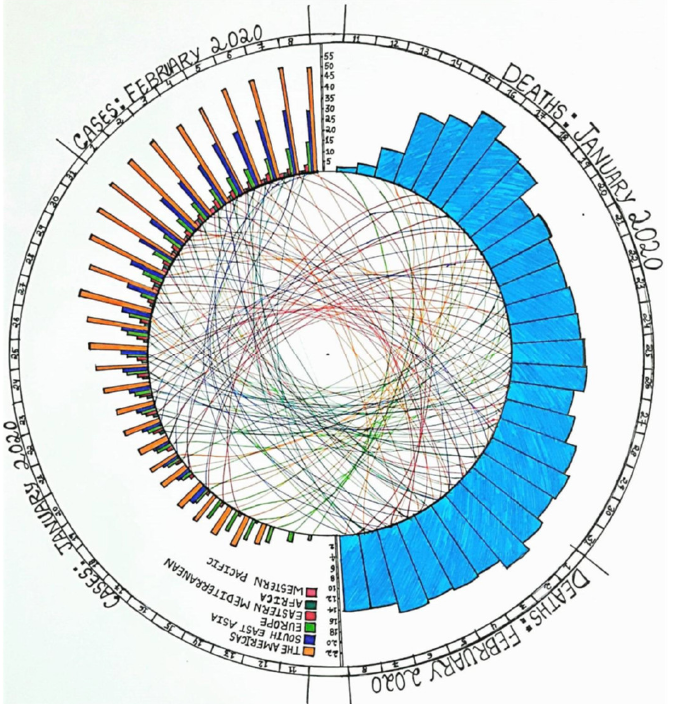
Figure 1. Initial epidemiology of COVID-19 in 2020. This circular plot represents the progressive increase in the number of infections/cases in the beginning of 2020 world wide. The left half of the circle shows the number of increasing cases per country over a period of one month (11 January to 8 February 2020). Right half of the circle shows the number of deaths over the same period of time from the countries listed taken together. Correlations are shown as lines in the center of the circle connecting the relevant data points from two halves of the circle.